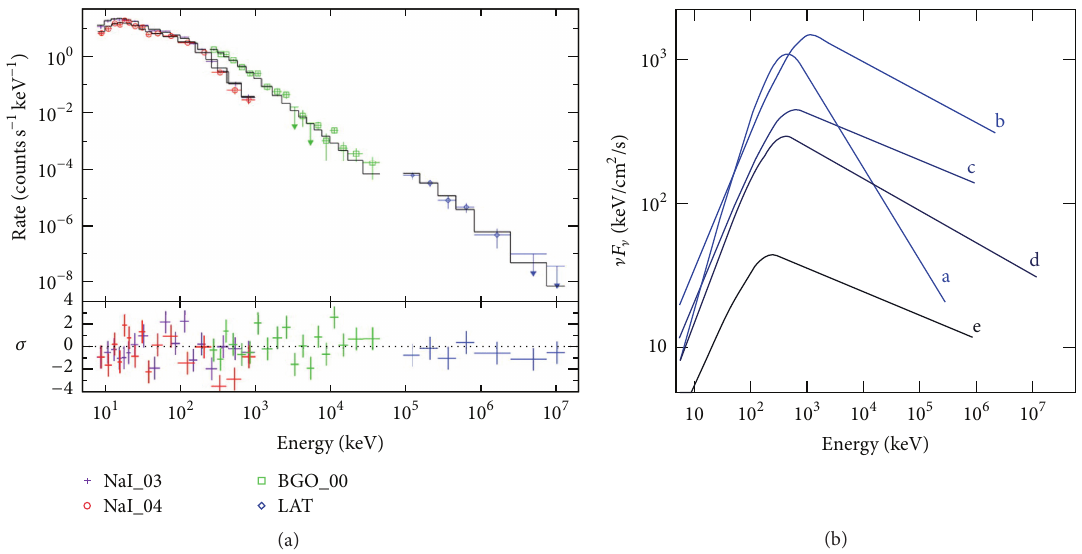
Figure 4: Spectra of GRB 080916C at the five time intervals (a–e) defined in Figure 3 are fitted with a “Band” function. (a) Count spectrum for NaI, BGO, and LAT in time bin b. (b) The model spectra in ] 𝐹 ] units for all five time intervals, in which a flat spectrum would indicate equal energy per decade of photon energy, and the changing shapes show the evolution of the spectrum over time. The “broken power law” figure adopted from Abdo et al.